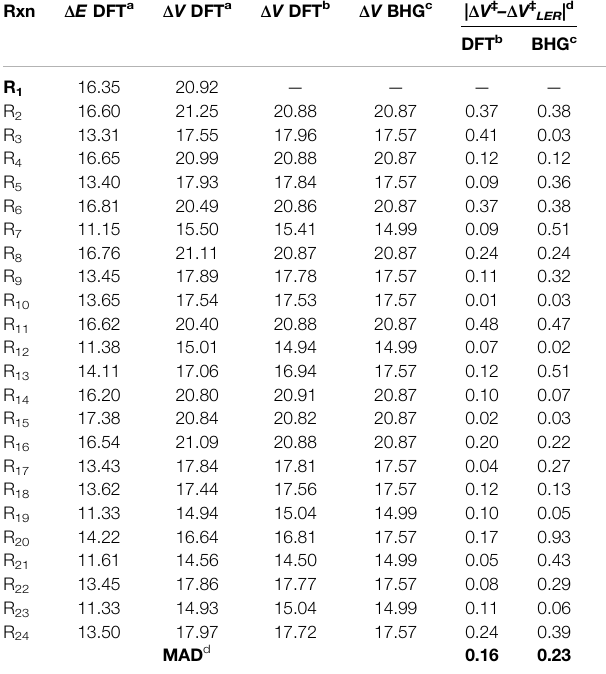
TABLE 3 | Classical reaction energies Δ E , barrier heights Δ V ‡ , and absolute deviations between the calculated barrier and those computed from LER expressions and barrier height grouping (BHG) approaches at 0K. Zero-point energy corrections are not